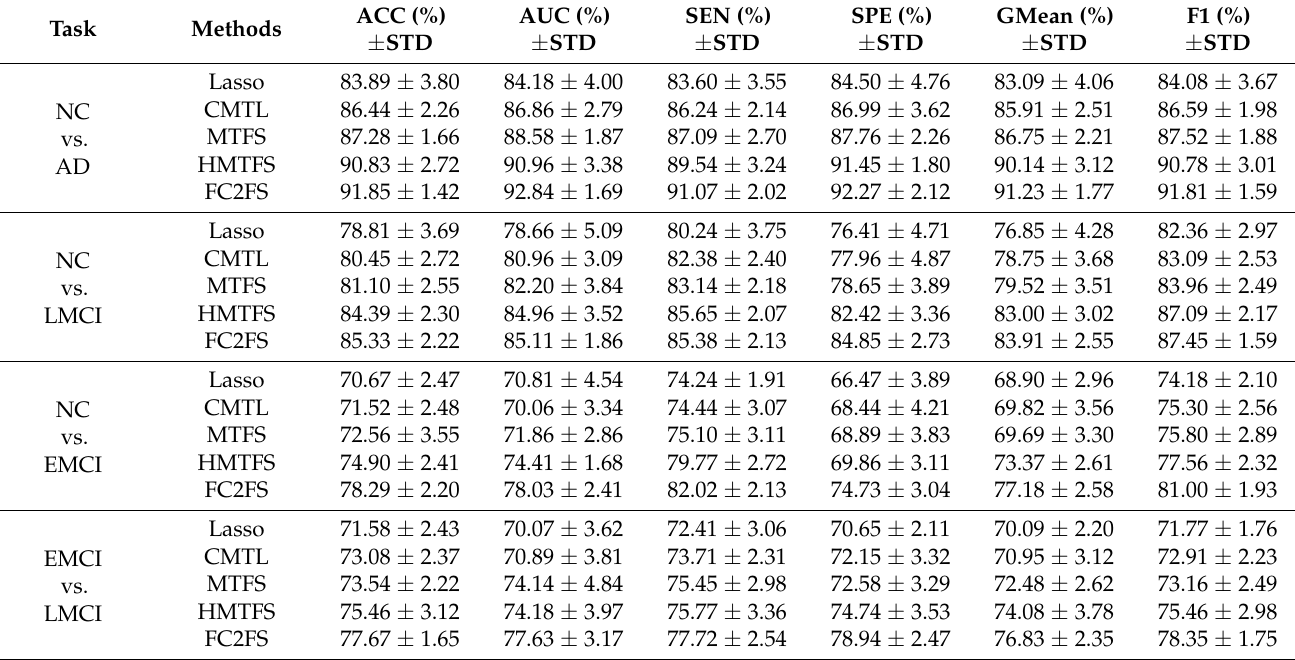
Table 3. Classification performance of different